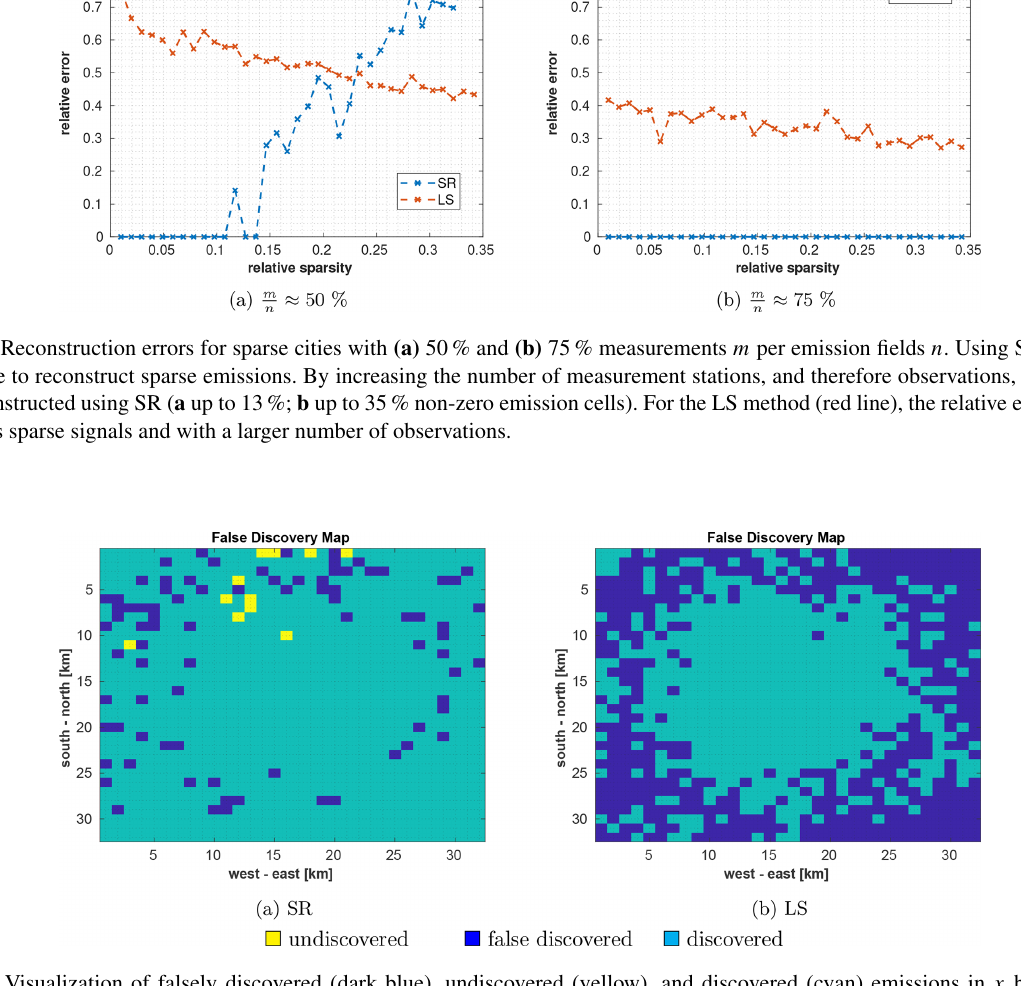
Figure C2. Visualization of falsely discovered (dark blue), undiscovered (yellow), and discovered (cyan) emissions in x by (a) SR and (b)